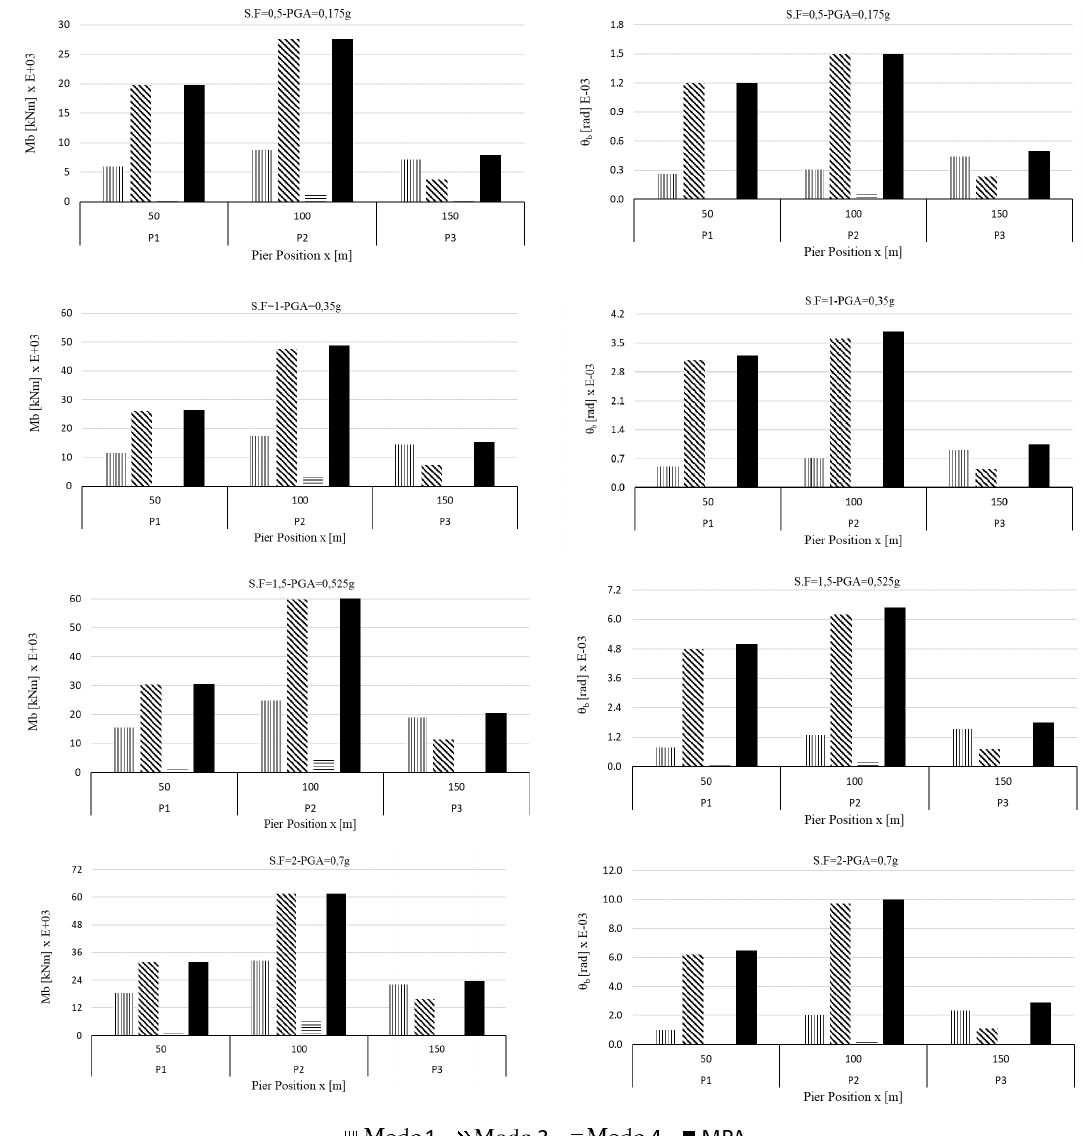
Figure A3. Irregular bridge—bending moment (M b ) and curvatures (q b ) at the hinge location, derived by performing nonlinear dynamic analysis and modal pushover according to each single mode (PGA from 0.175 to 0.7 g).